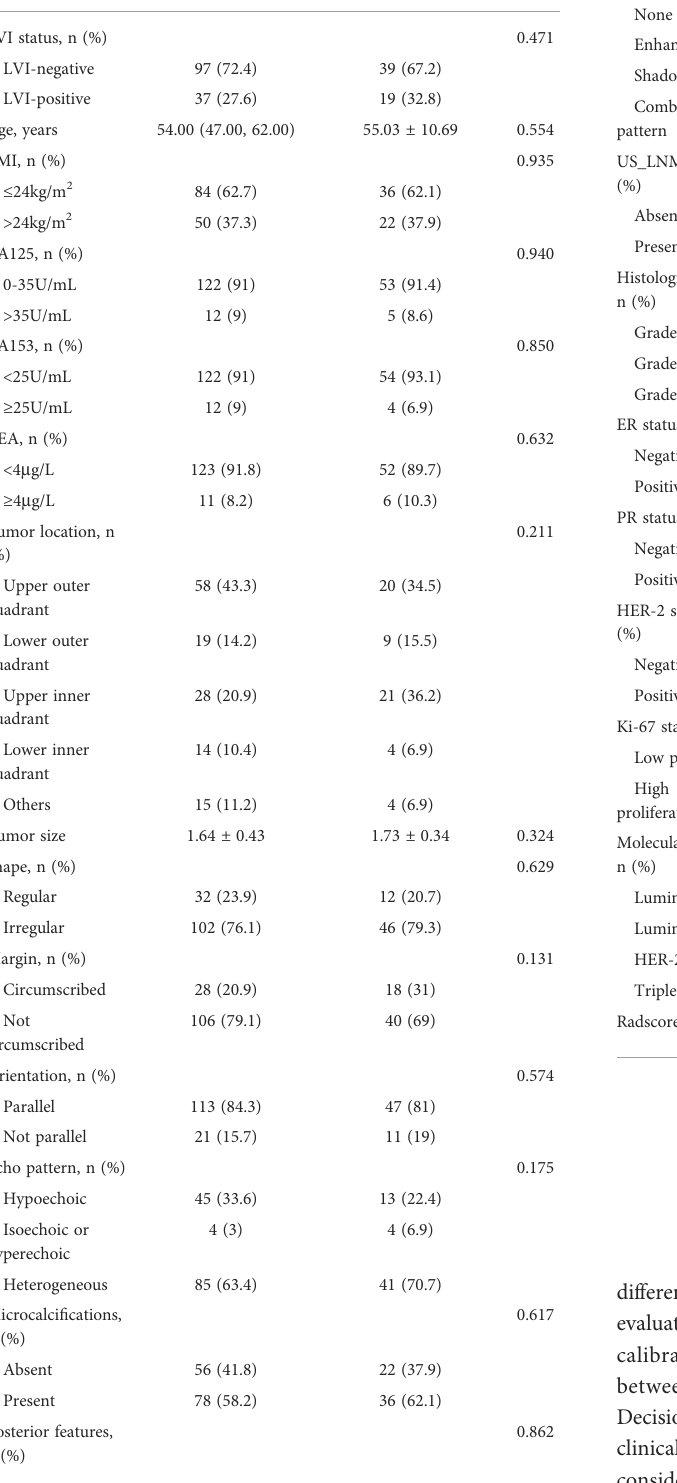
TABLE 3 Comparisons of baseline characteristics in the training and validation